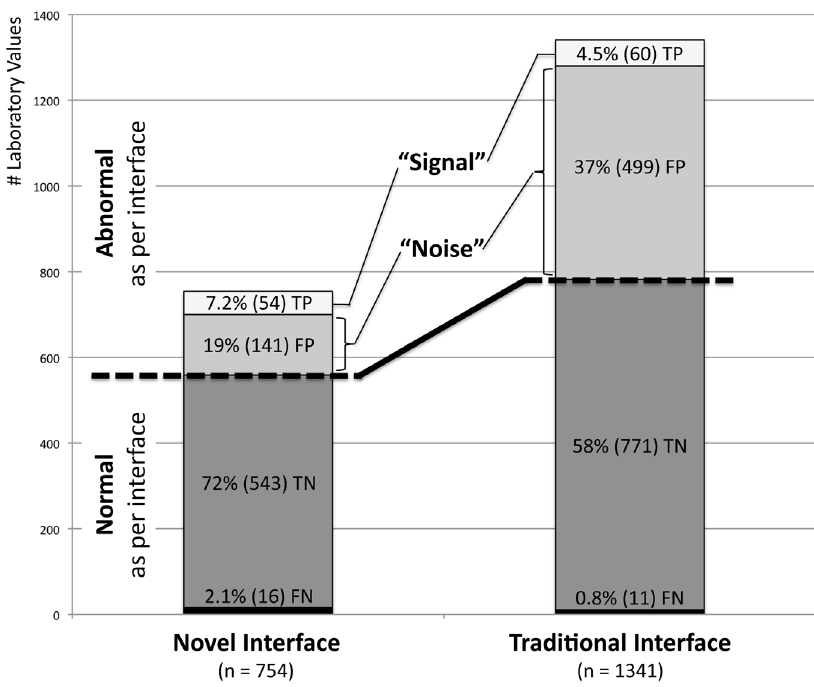
Figure 2. Normal and abnormal Laboratory Values displayed by both Interfaces subclassified according to Gold Standard Judgment. Percentage of true positive (TP), false positive (FP), true negative (TN) and false negative (FN) values shown relative to the total number of laboratory values displayed by each interface as percent (number). Truly abnormal laboratory test results (TP) commonly signal health-care providers the need to take action with regards to their patients’ health status. Laboratory values falsely indicated as abnormal (FP) represent in this sense a distraction or ‘‘noise’’ clouding this important ‘‘signal’’. While an abnormal value in the traditional interface reflects a true abnormality in roughly 1 out of 9 times this ‘‘signal-to-noise ratio’’ is 1 in 4 (i.e. more than twice as high) in the novel interface.